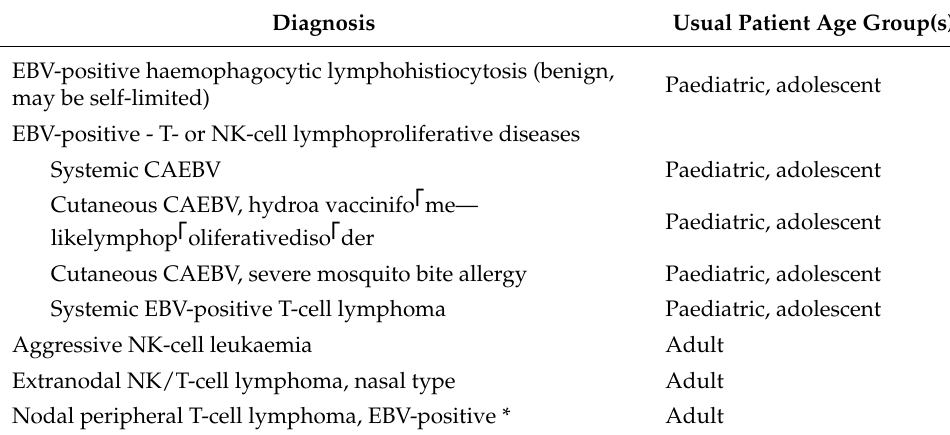
Table 1. Classification of EBV-positive T-cell and NK-cell proliferations.